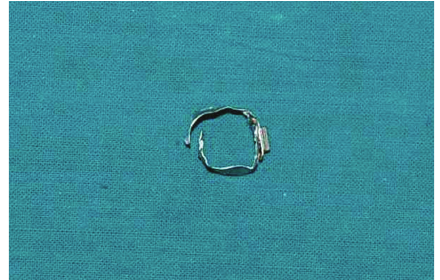
Figure 3: Retrieved molar